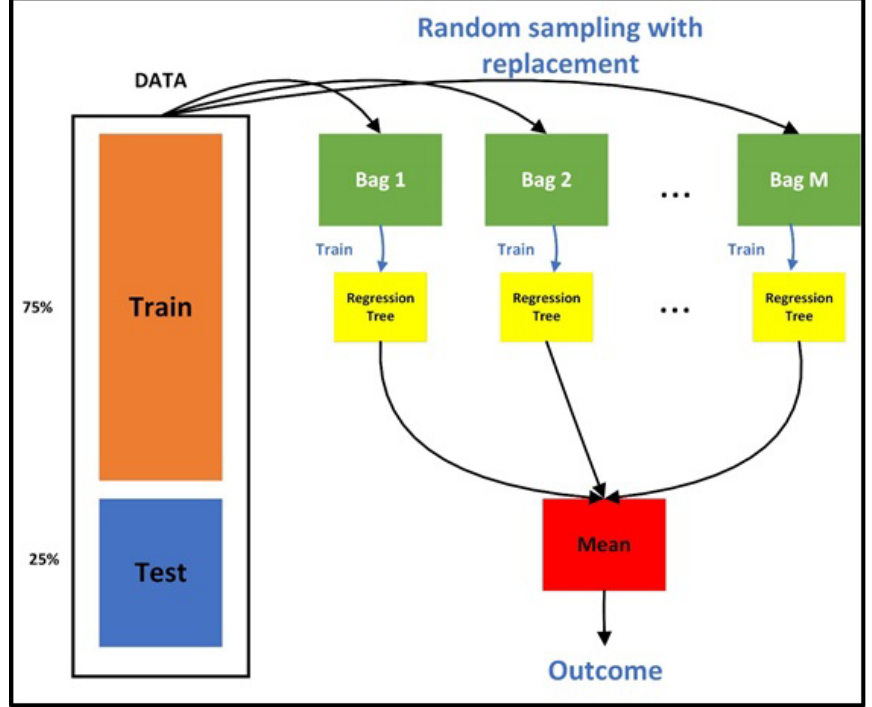
Figure 4. Training procedure of bagged regression tree (BRT).